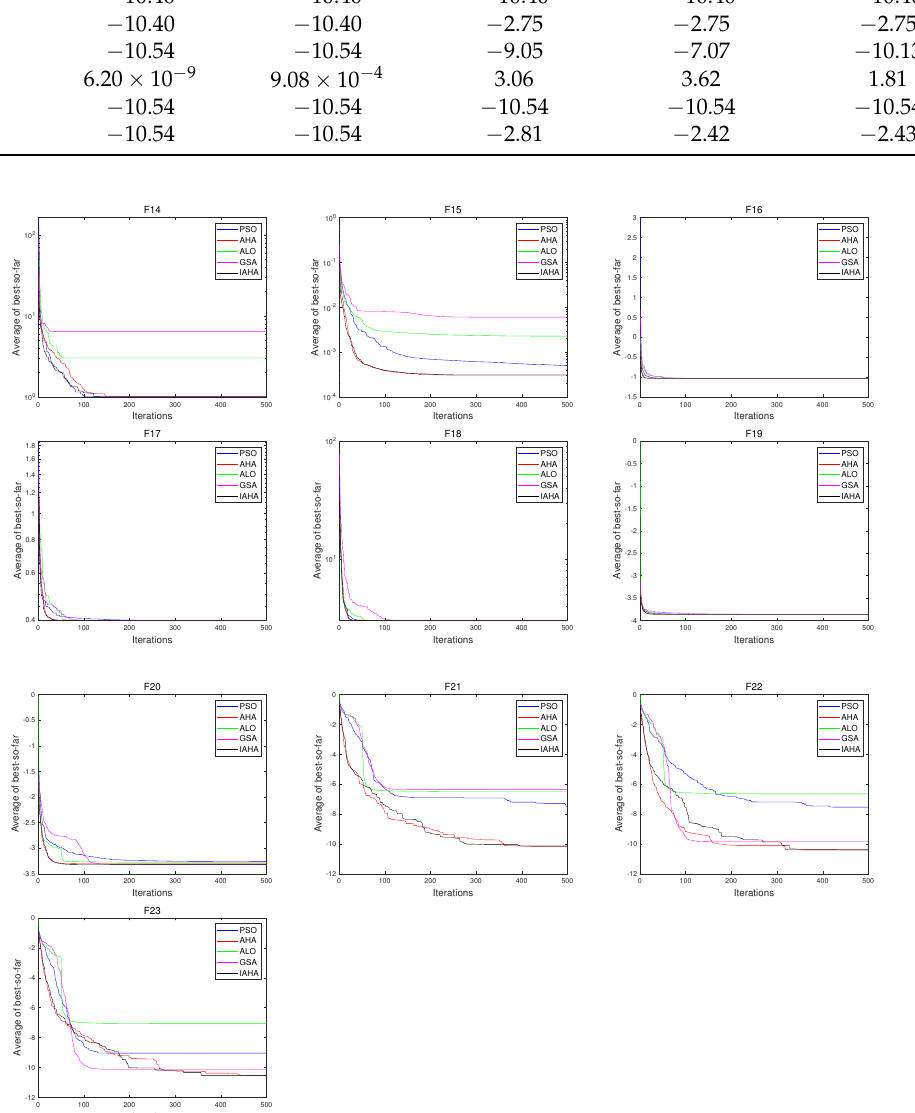
Figure 4. Average convergence curve of different optimization algorithms on low—dimensional multi—peak test